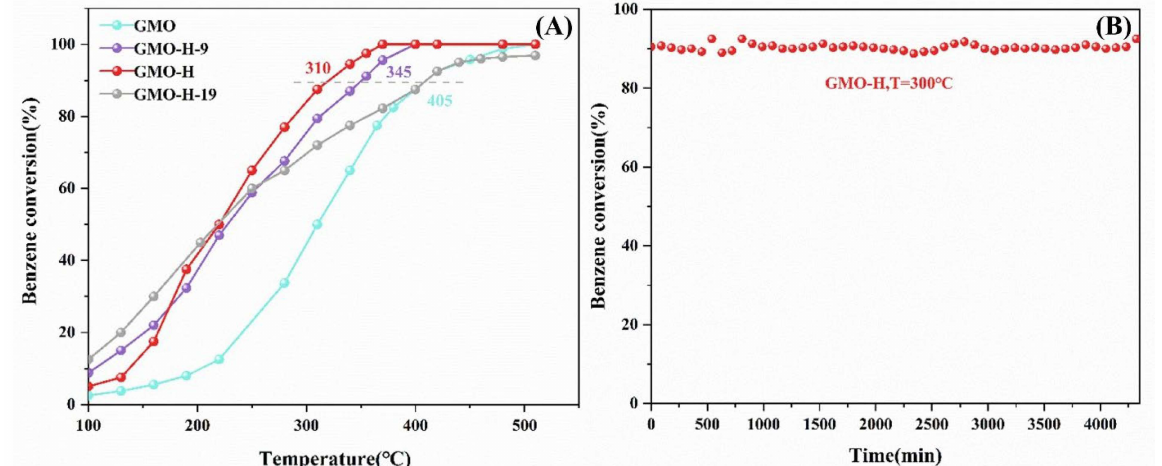
Figure 6. ( A ) Effect of conversion of Benzene on GMO, GMO-H-9, GMO-H, and GMO-H-19; ( B ) 72 h stability of GMO-H at 300 ◦ C. (Reaction conditions: 0.10 g catalyst, 600 ppm C 6 H 6 , 20% O 2 , balance N 2 , total flow = 50 mL min − 1 , WHSV = 30,000 mL g − 1 h − 1 , each point corresponds to steady-state